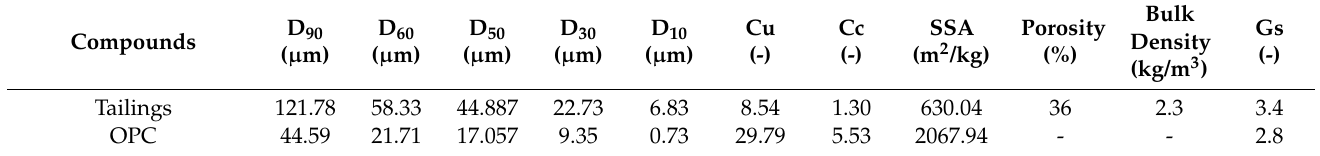
Table 1. Physical characteristics of tailings and ordinary Portland